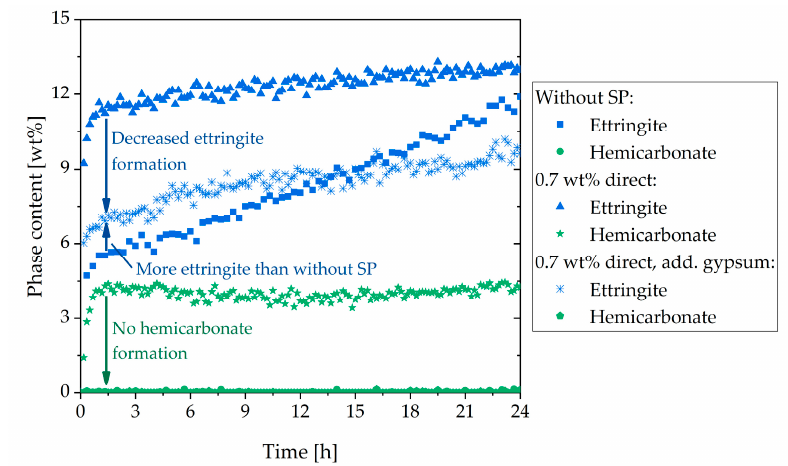
Figure 15. Ettringite and hemicarbonate content of the sample without SP, with direct addition of 0.7 wt% of SP, and with additional gypsum and direct addition of 0.7 wt% of SP.